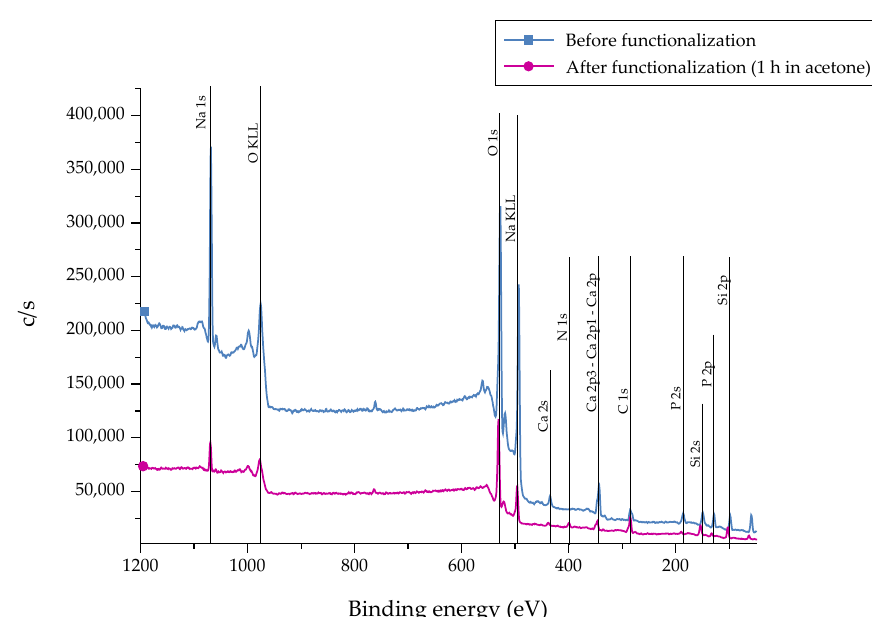
Figure 3. XPS spectra of 45S5 bioactive glass (BG) surfaces before and after the silanization process in acetone +2 vol % APTS for 1 h.